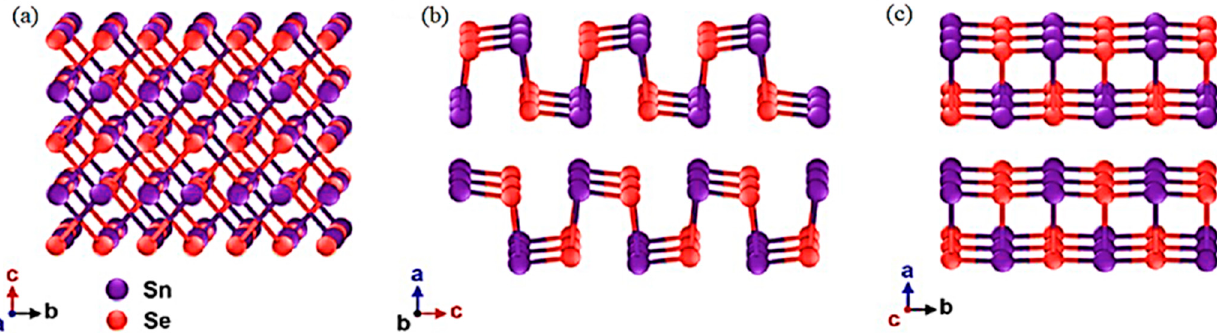
Figure 1. Crystal structures along with the ( a – c ) axial directions of SnSe. Reprinted with permission from [78].